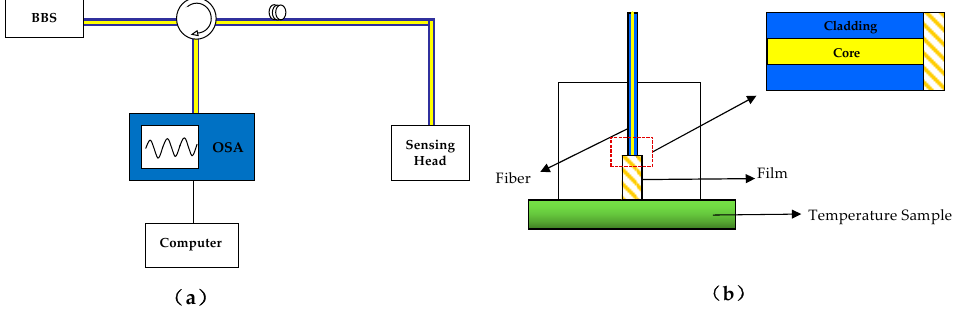
Figure 2. ( a ) The experimental setup of the proposed fiber-optic sensor; ( b ) Schematic of the sensing head for temperature measurement.